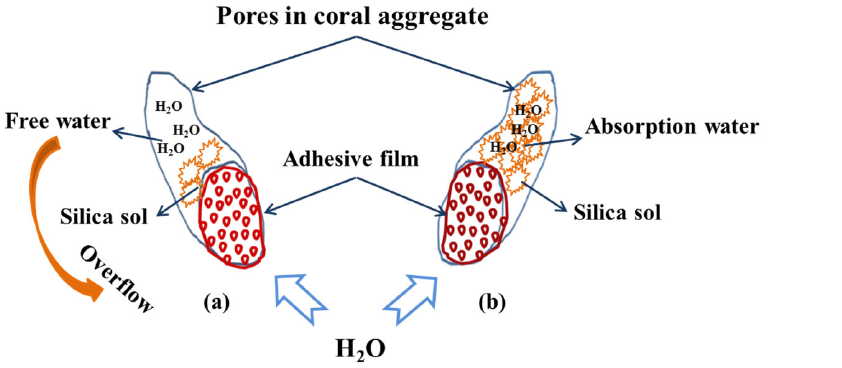
Figure 8. The schematic diagram of the interaction process between the SS-treated coral aggregate and water: ( a ) overflow process and ( b ) absorption process.